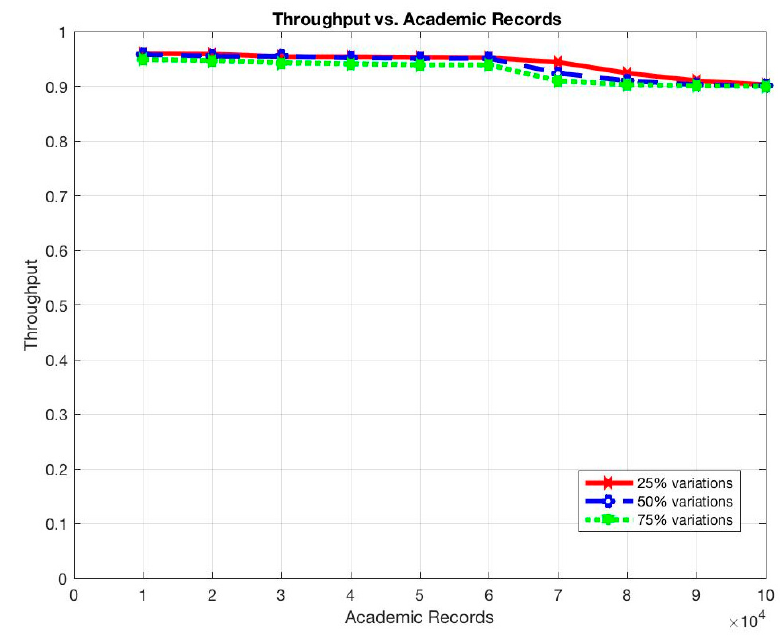
Figure 12. Throughput vs. Academic Records.